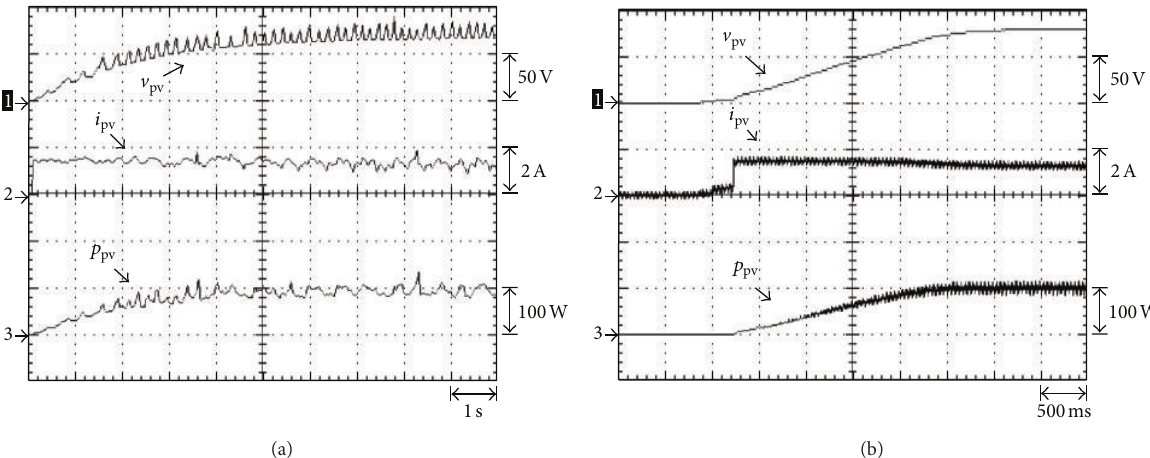
Figure 9: Startup waveforms under 1000W/cm 2 illumination intensity: (a) based on the perturbation and observation method—(1) V 𝑖 ; (3) 𝑝 . (b) Based on the proposed HMPPT method— (1) V pv pv